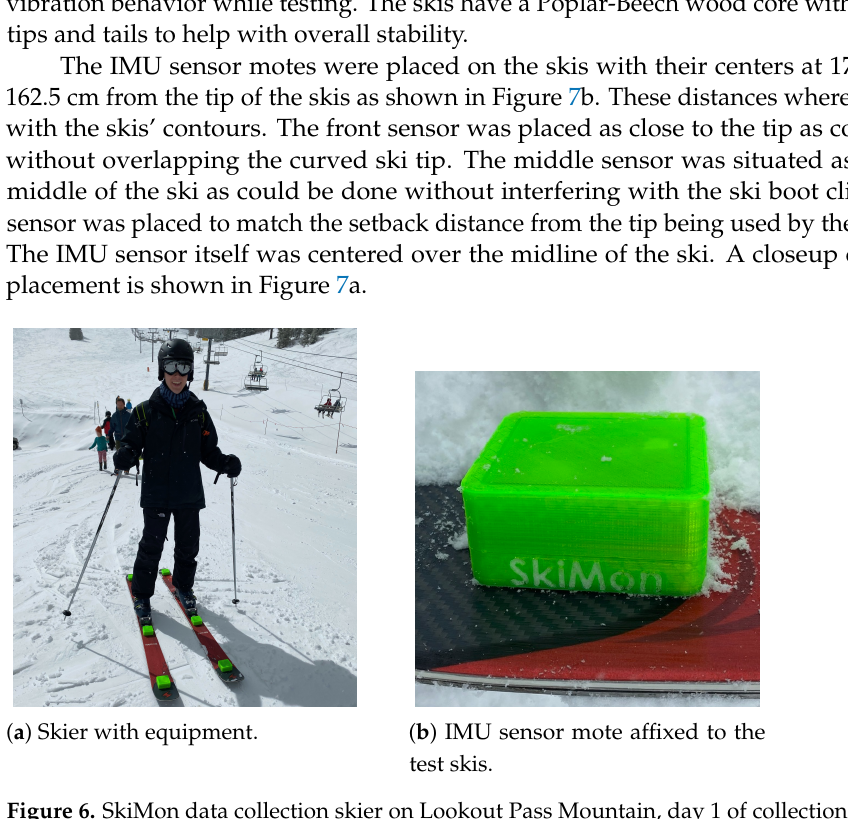
Figure 6. SkiMon data collection skier on Lookout Pass Mountain, day 1 of